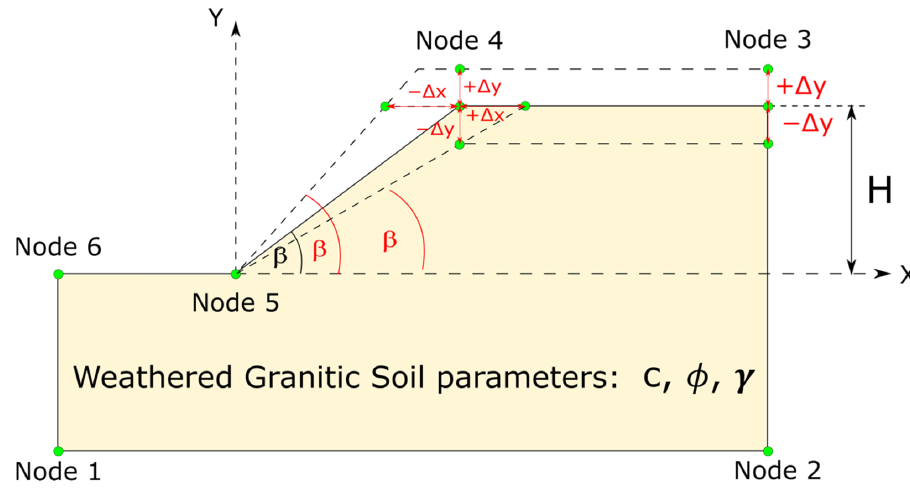
Figure 3. Slope model template diagram.